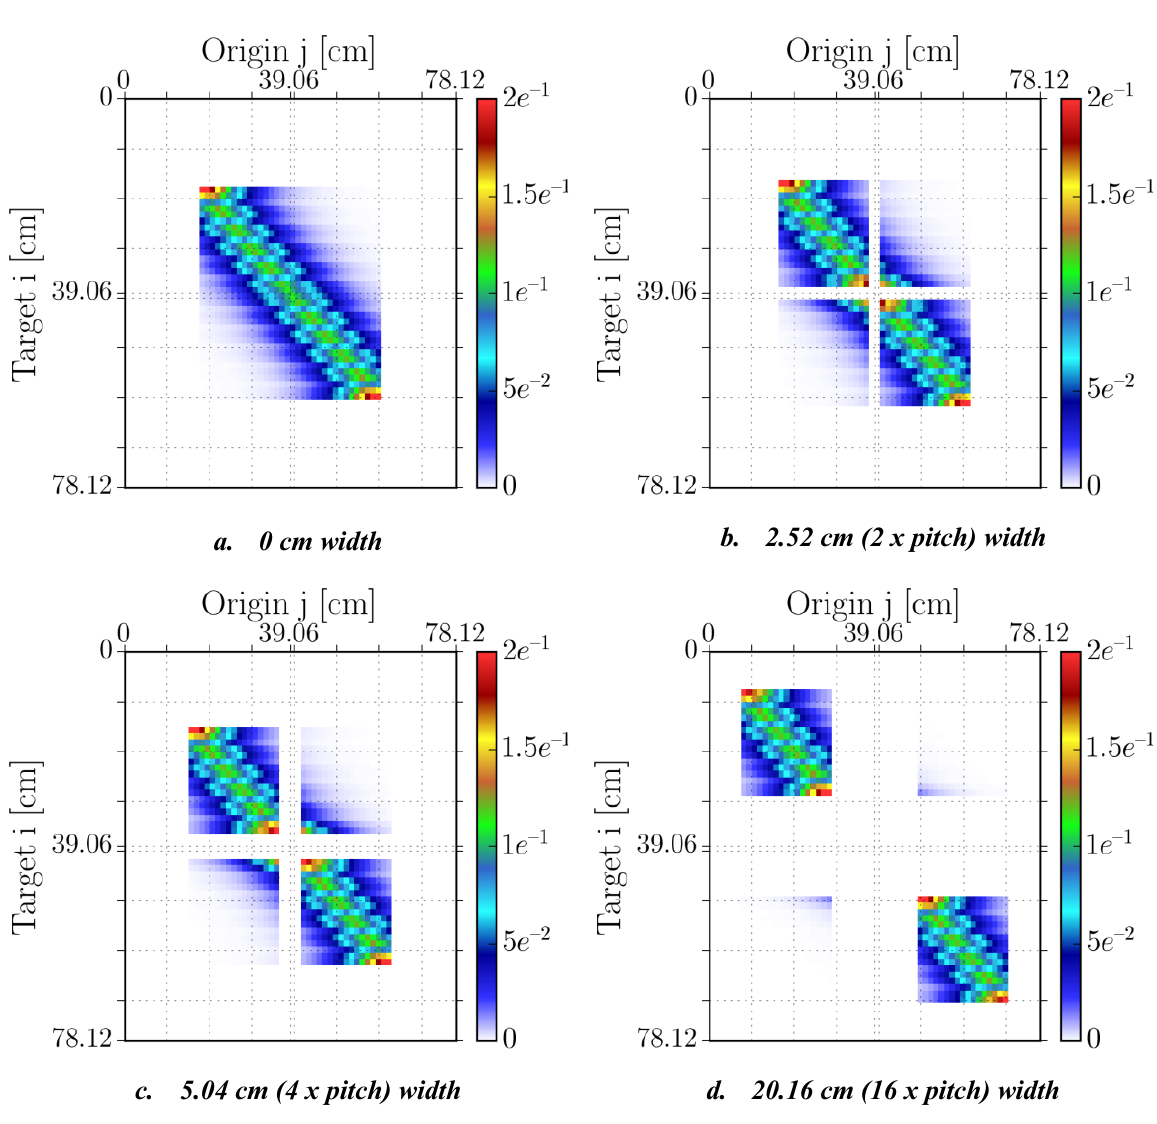
Figure 2. M N matrices for the UOX – UOX geometry, for different water blade widths. The color O P O scale expresses the propagation